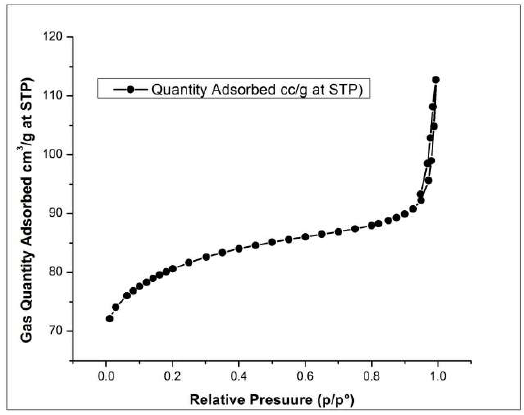
Figure 11. BET of HEC/PANI-PPy.